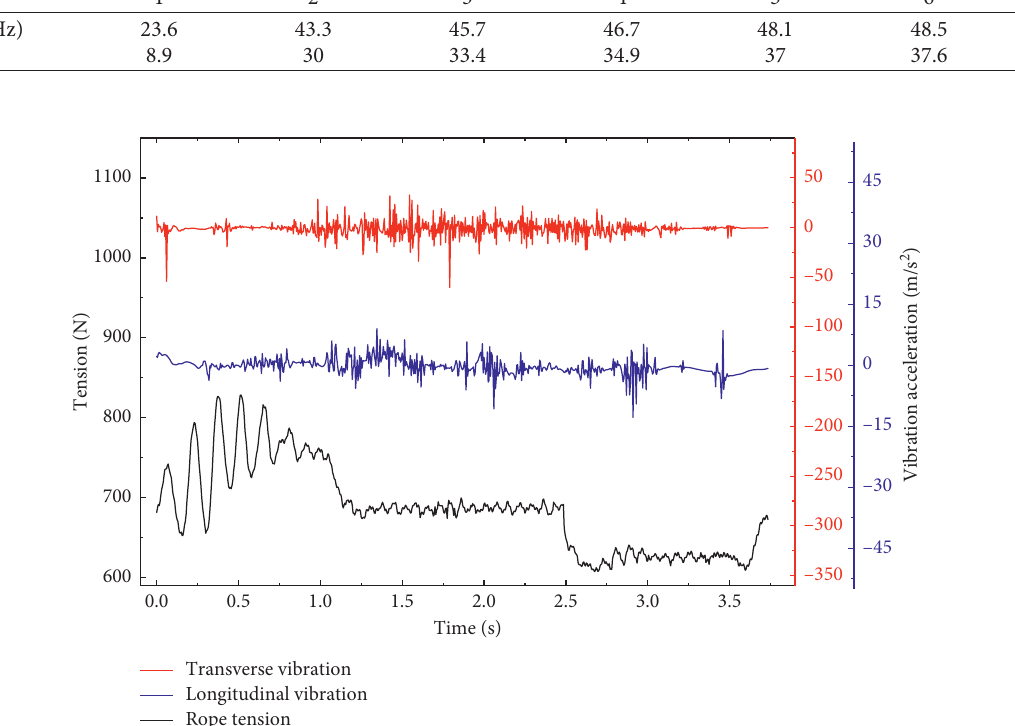
Figure 8: Rope tension and vibration without periodic excitation.